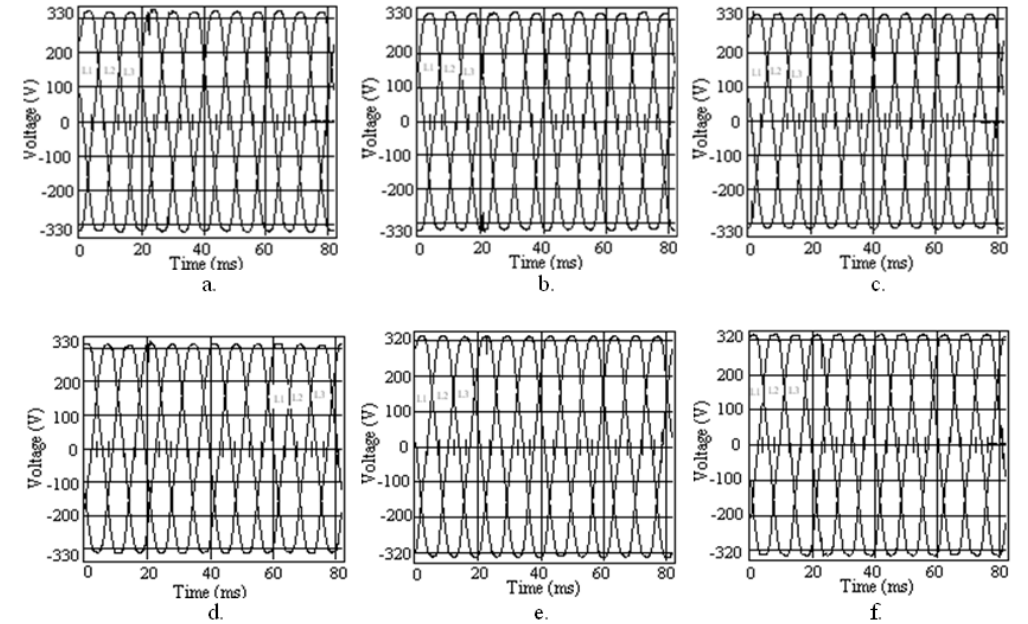
Figure 20. Fast voltage transients from the electrical power substation.